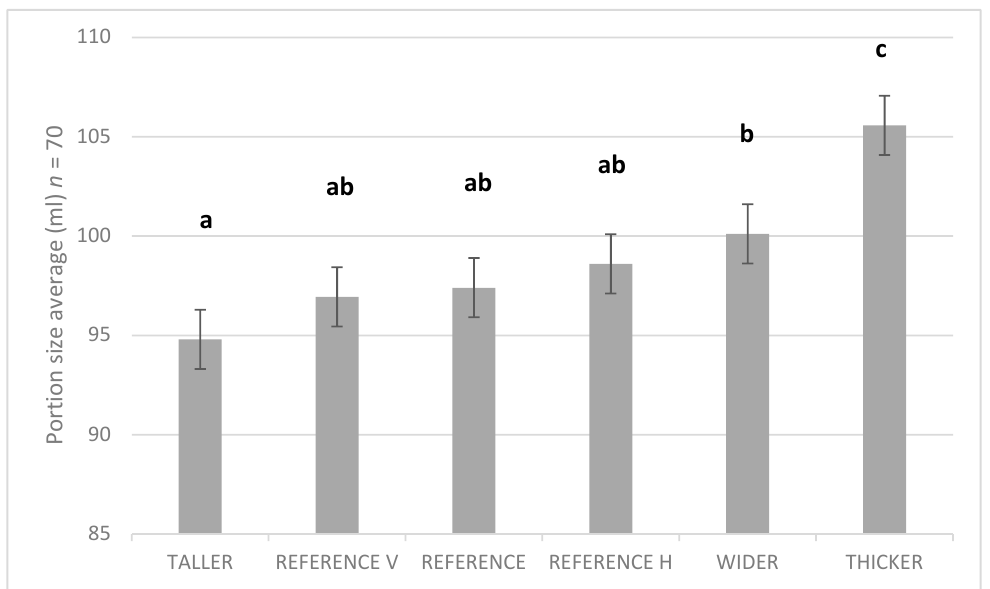
Figure 2. Mean (± SEM) ideal self-selected portion size for the six ice cream shapes. Different letters (a, b, c) account for significant difference between ice cream shapes.